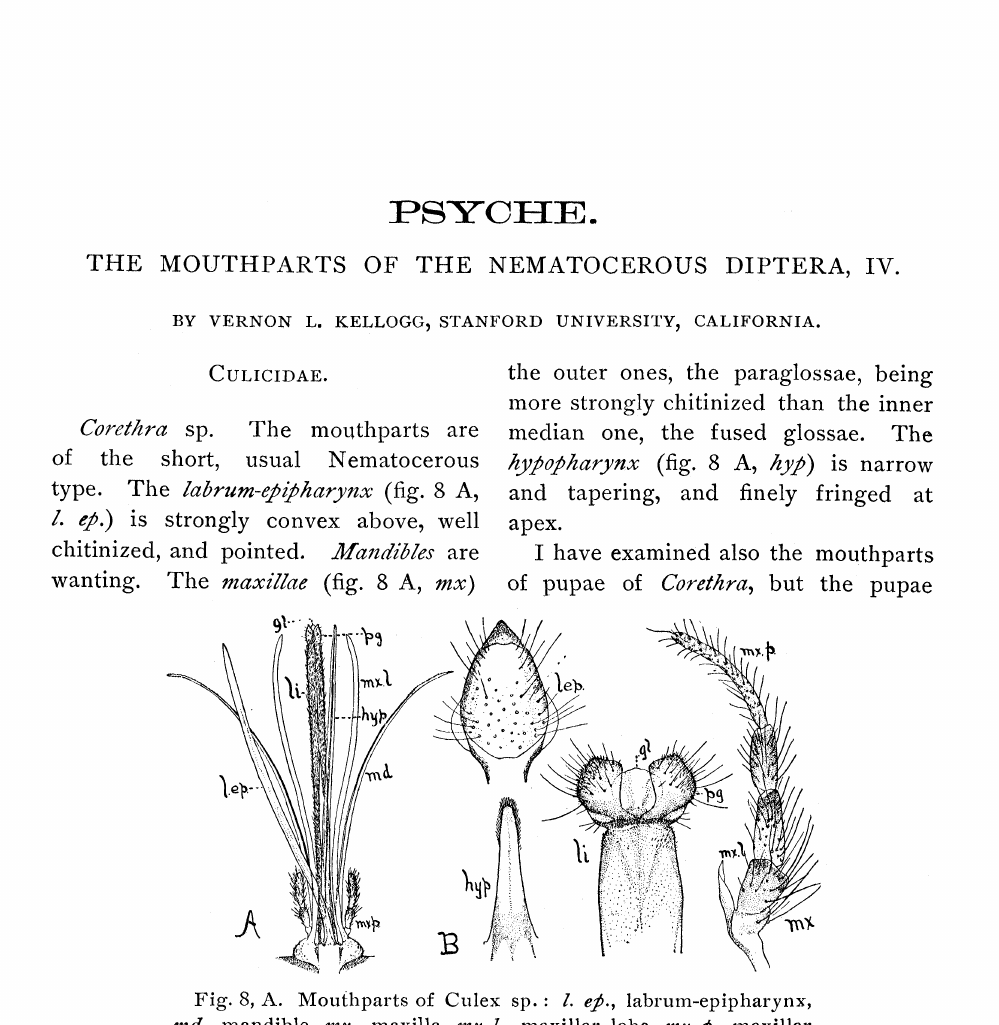
Fig. 8, A. Moufhparts of Culex